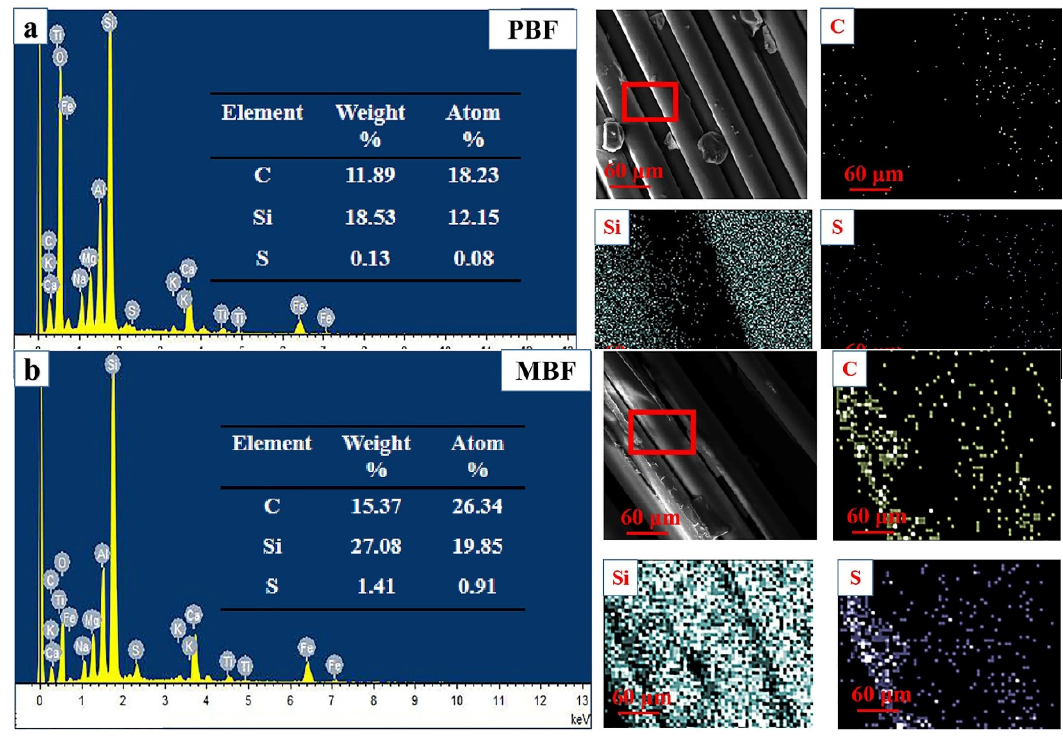
Figure 3. Energy dispersive X-ray (EDX) data, SEM images and the corresponding element mapping for ( a ) PBF and ( b ) MBF.